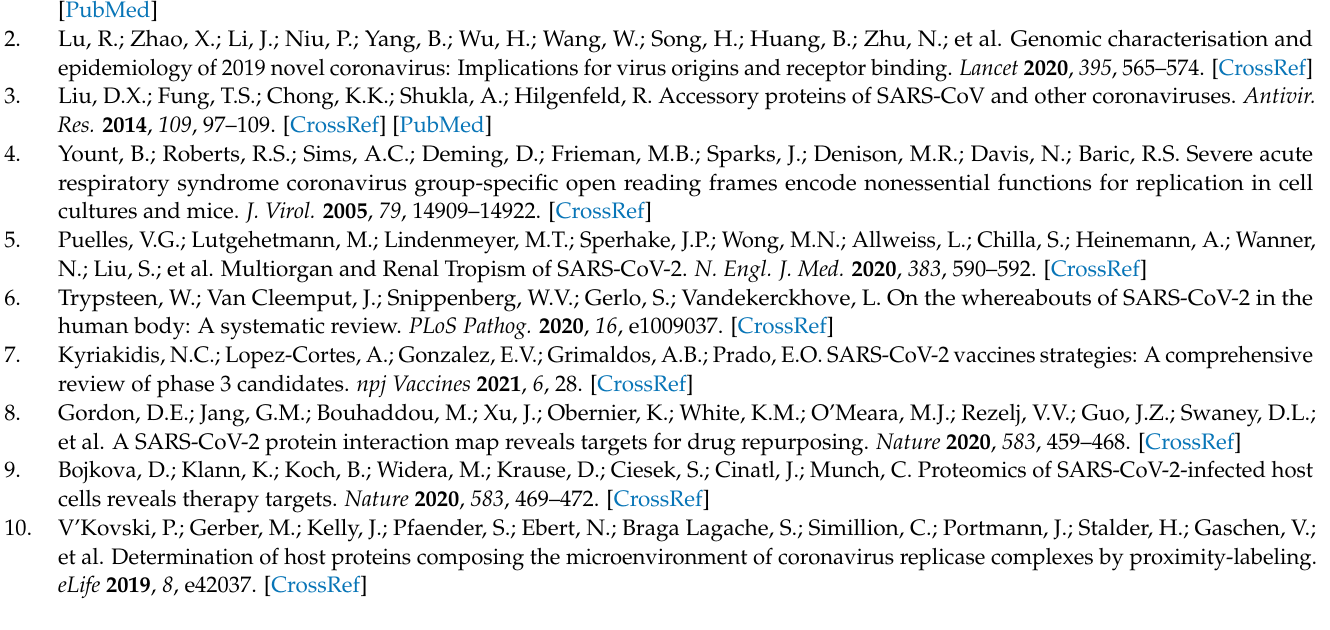
Table 1. Table S2: Summary of the statistical analysis of the signaling pathway luciferase reporter screen. The p values were determined by two-tailed Student’s t test. Boxes in green and red indicate positive hits in the screen, which are also shown in Table